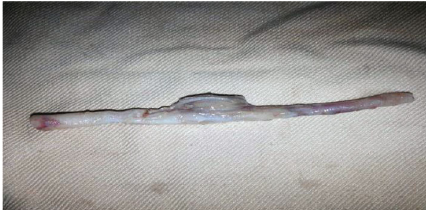
Figure 7: Femoral artery pathology specimens from experimental